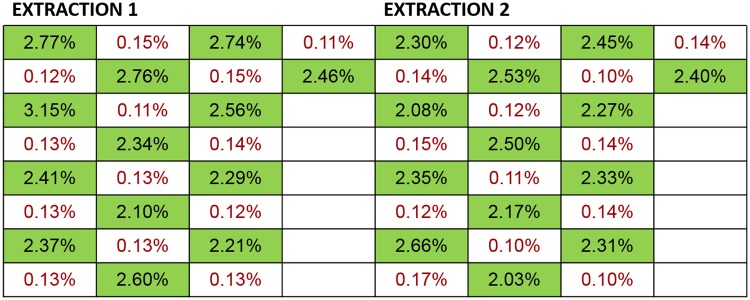
DF (%) results, TECAN extractions 1 and 2, carryover/cross-contamination testing.Relative sample positions were maintained from extraction through the entire myTAIHEART workflow (extraction through qGT). Green positions = high DF samples; white positions = low DF samples.